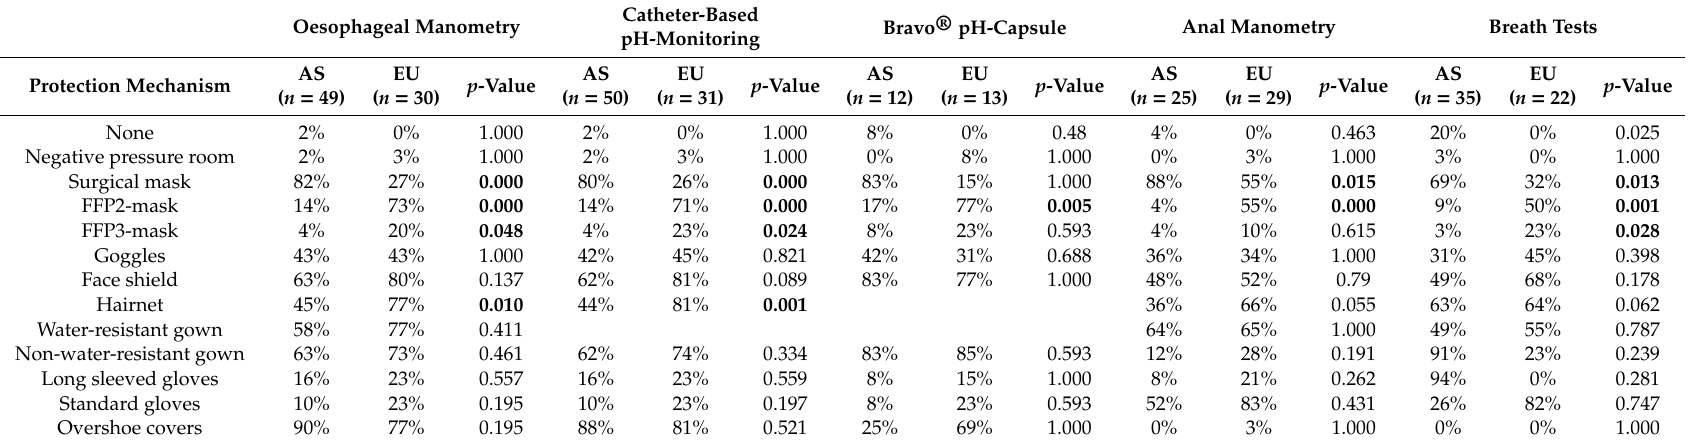
Table 1. Personal protective equipment for di ff erent gastrointestinal motility investigations.